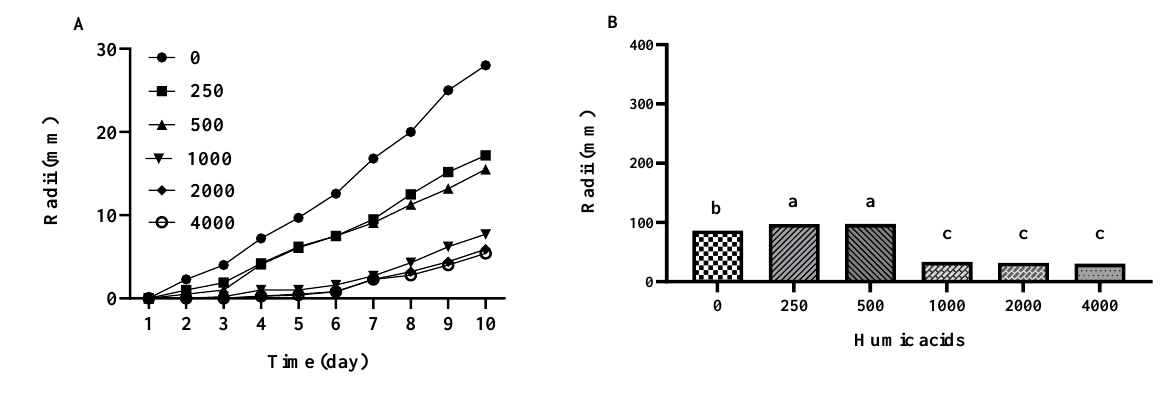
Fig. 6 Effect of different rates of humic acids extracts on Serendipita indica growth A, Dose-response curves for the growth of S. indica on solidified broth medium amended with seven concentrations of humic acids (0, 250, 500, 1000, 2000 and 4000 ppm L -1 ). ( Note: The diameter of fungus was divided by its average growth on four per- pendicular axes bisecting the center of the colony. P < 0.05. Values are mean ± SE (n = 5). B , The mycelia mats (dry biomass) yield of S. indica growing in medium at seven humic acid levels (0, 250, 500, 1000, 2000 and 4000 ppm L -1 ). P < 0.05. Values are mean ± SE (n = 5).